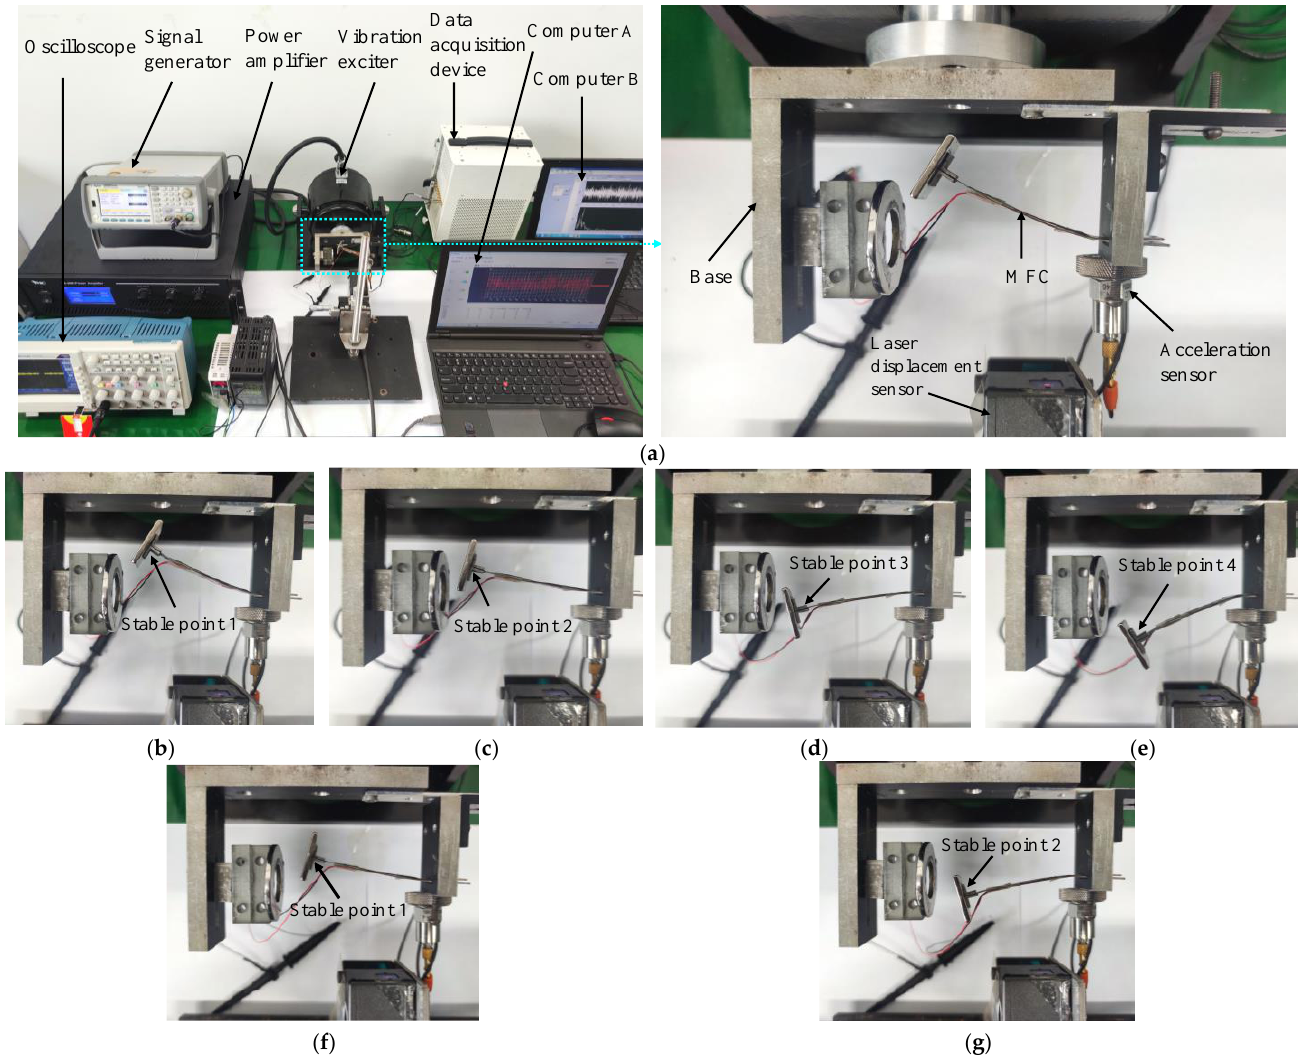
Figure 7. ( a ) The experimental setup; the stable equilibrium points of the energy harvester under the quad-stable structural parameters ( d = 11 mm): ( b ) stable point 1, ( c ) stable point 2, ( d ) stable point 3, and ( e ) stable point 4; the stable equilibrium points of the energy harvester under the bi-stable structural parameters ( d = 15 mm): ( f ) stable point 1 and ( g ) stable point